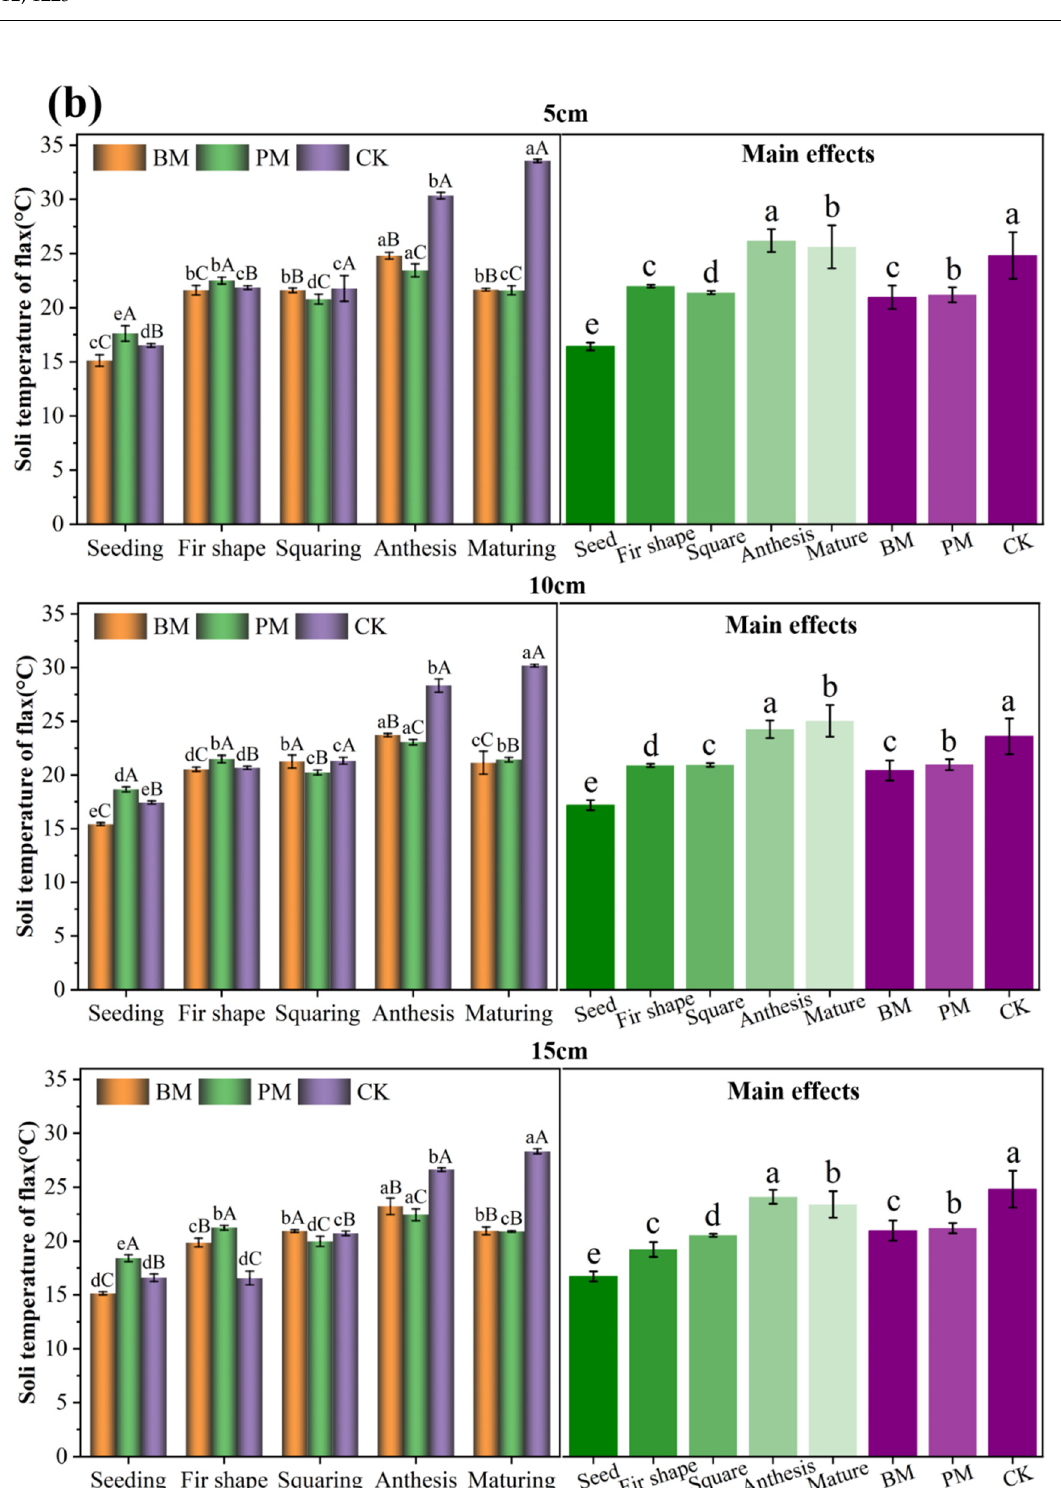
Figure 9. Changes in plastic film mulching on soil temperature in 2021. ( a ) Soil temperature of maize at 5, 10, and 15 cm depth; ( b ) soil temperature of flax at 5, 10, and 15 cm depth. Values represent the mean ± standard deviation. Using Duncan’s multiple-range test, different lowercase letters indicate significant differences in soil temperature under different mulching methods at the same growth period ( p < 0.05), and different capital letters indicate significant differences in soil temperature at different growth stages under the same mulch control ( p < 0.05). BM, biodegradable paper mulch film; PM, white plastic mulch film; CK, not covered with film.